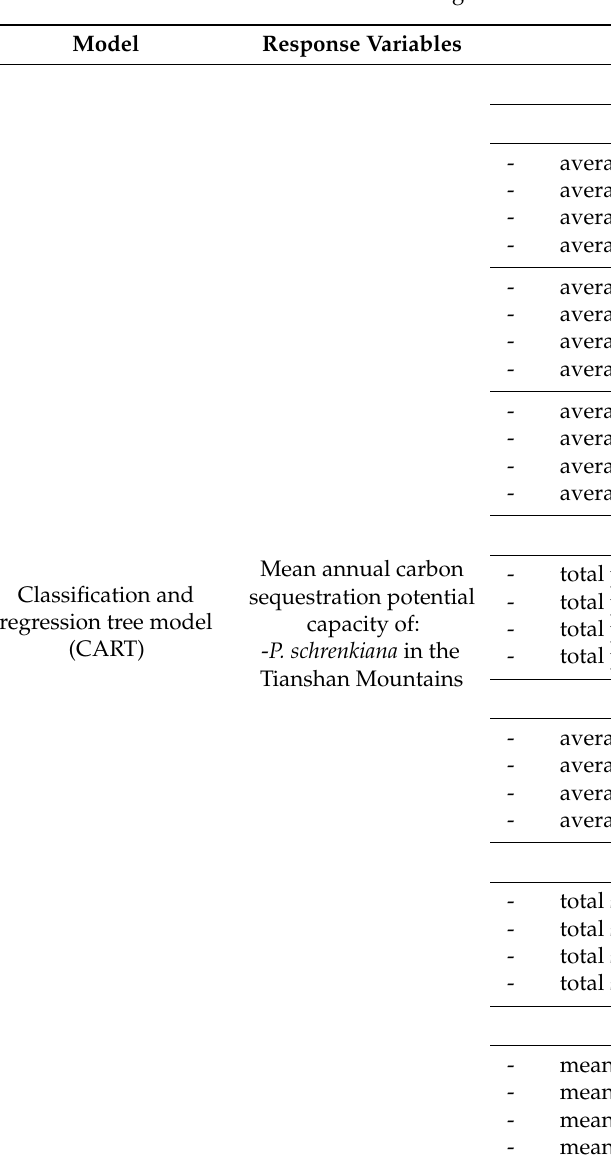
Table 1. Response and predictor variables used for modeling the relationship between carbon sequestration in aboveground biomass of P. schrenkiana and climatic